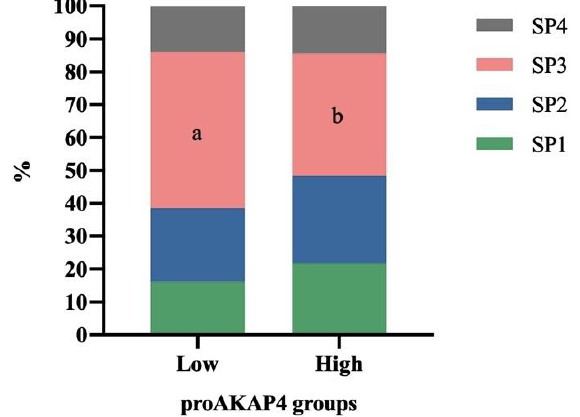
Figure 4. Distribution of the four motile sperm subpopulations (SP) identified in frozen–thawed horse ejaculates as having low (n = 23) or high (n = 25) proAKAP4 concentration (ng/10M spz). a,b Different letters indicate significant differences ( p ≤ 0.05) between proAKAP4 groups.